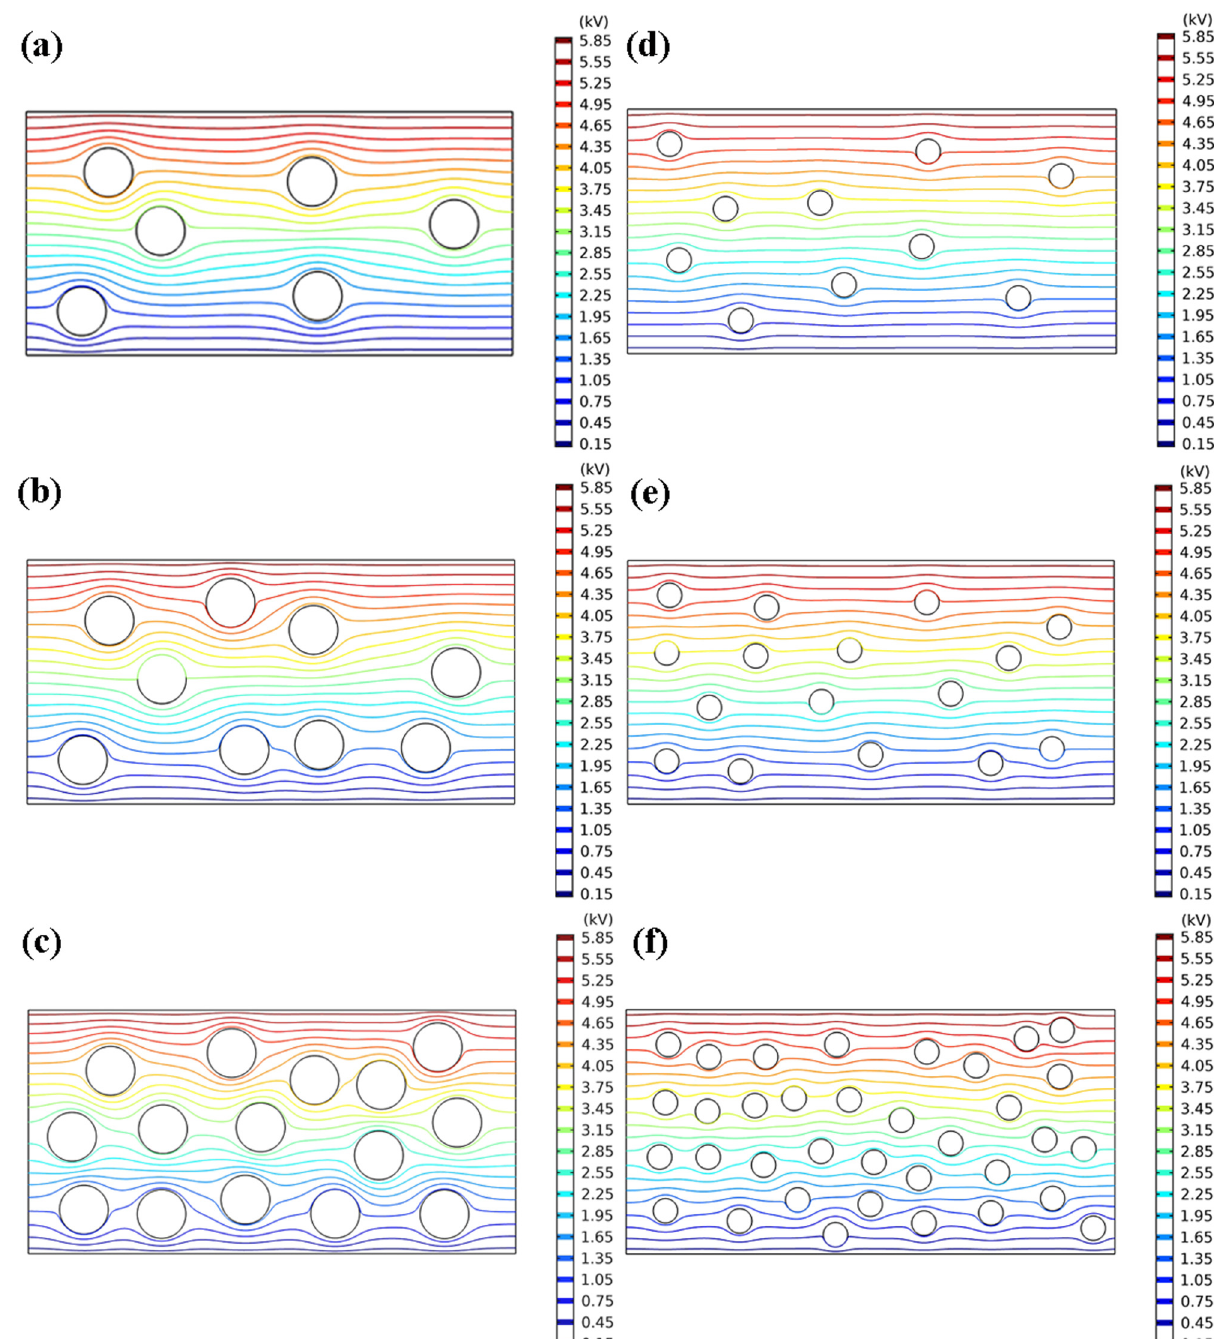
Figure 7: Simulation diagrams for the electrical potential distribution of the LDPE composite loaded with ( a ) 1 vol% CCTO, ( b ) 5 vol% CCTO, ( c ) 10 vol% CCTO, ( d ) 1 vol% CCTZO, ( e ) 5 vol% CCTZO, and ( f ) 10 vol% CCTZO